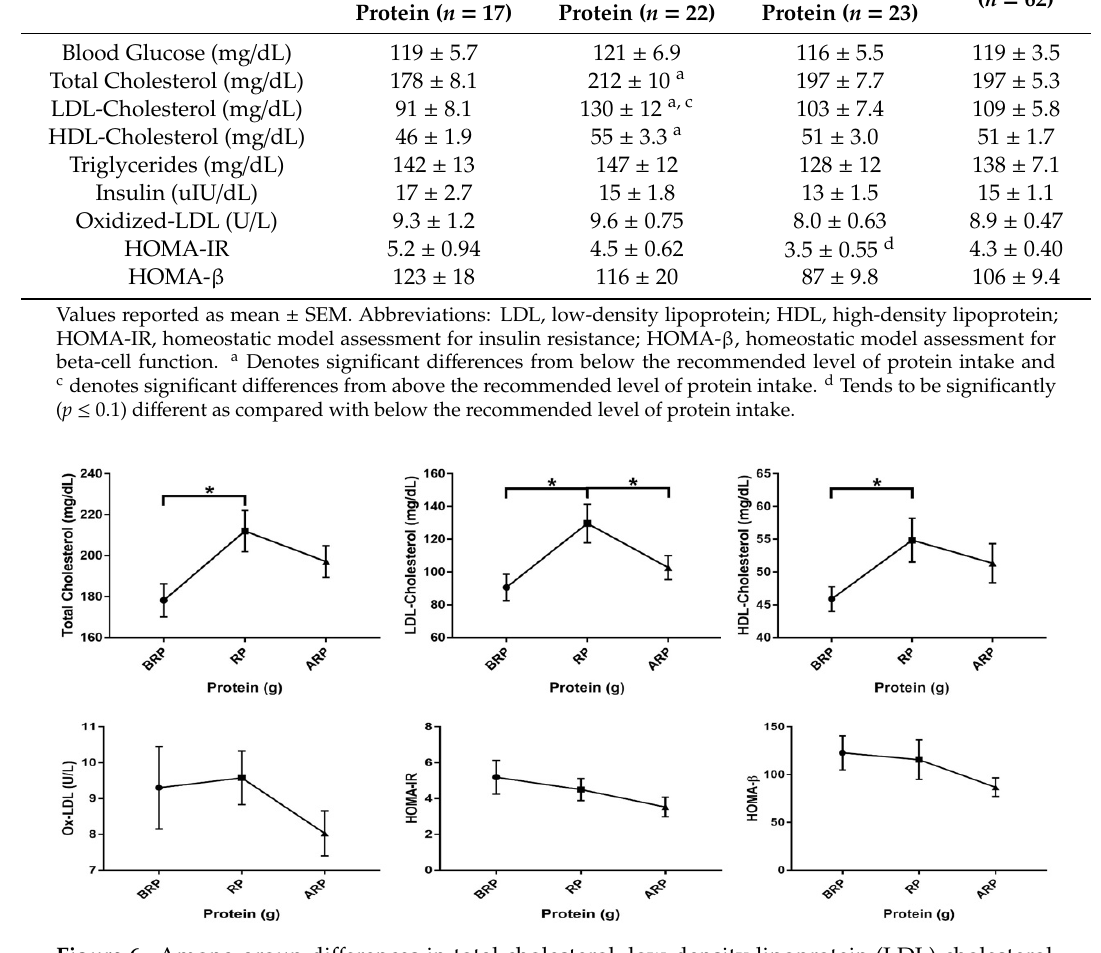
Table 5. Fasting lipid profile and glycemic control .